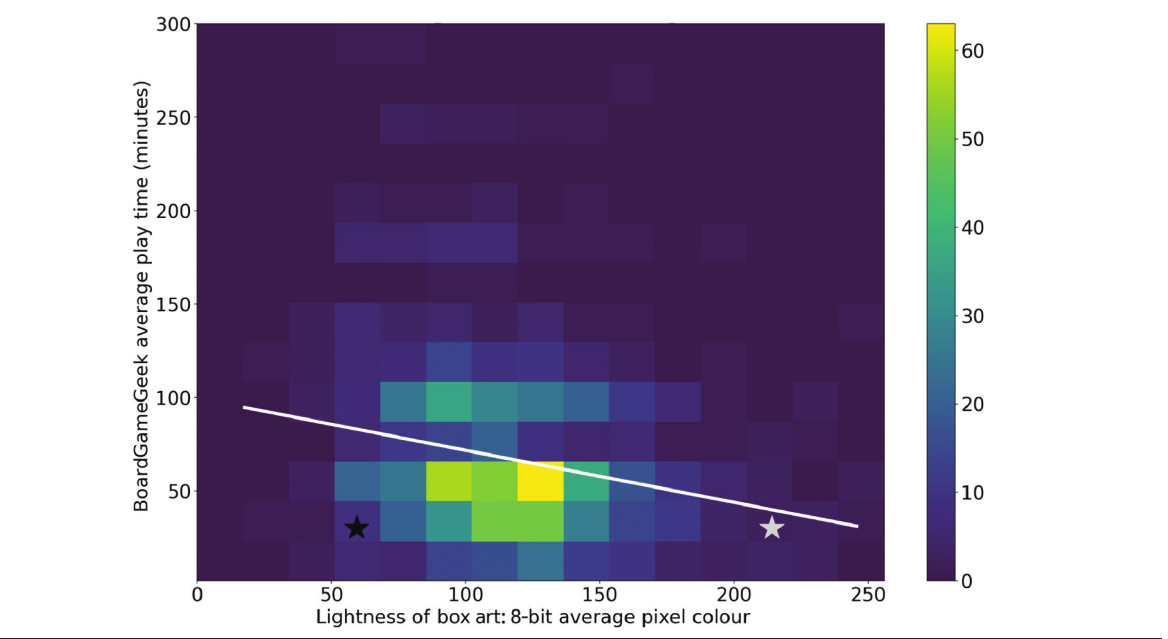
Figure 7. A 2D histogram of the average play time of the top 1,000 games from BoardGameGeek against the overall brightness of the box. The dark box is represented by a black star, and the light box is represented by a white star (Source: Authors,